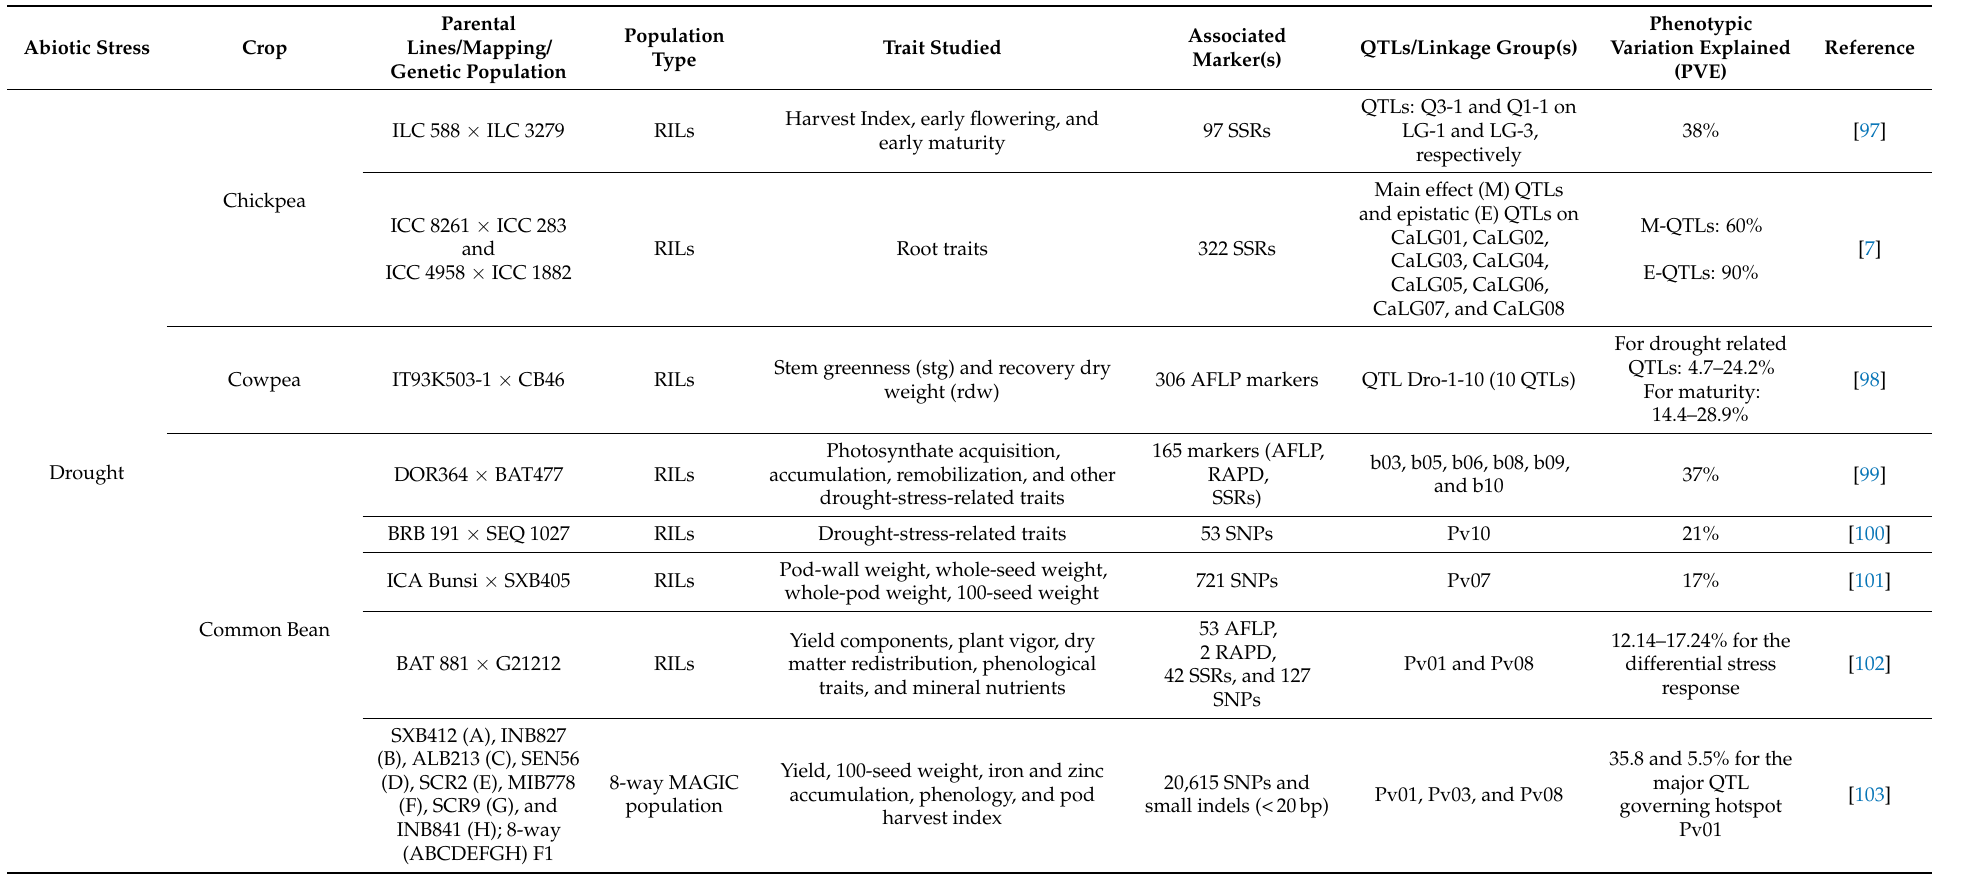
Table 3. QTLs identified for various abiotic stresses in